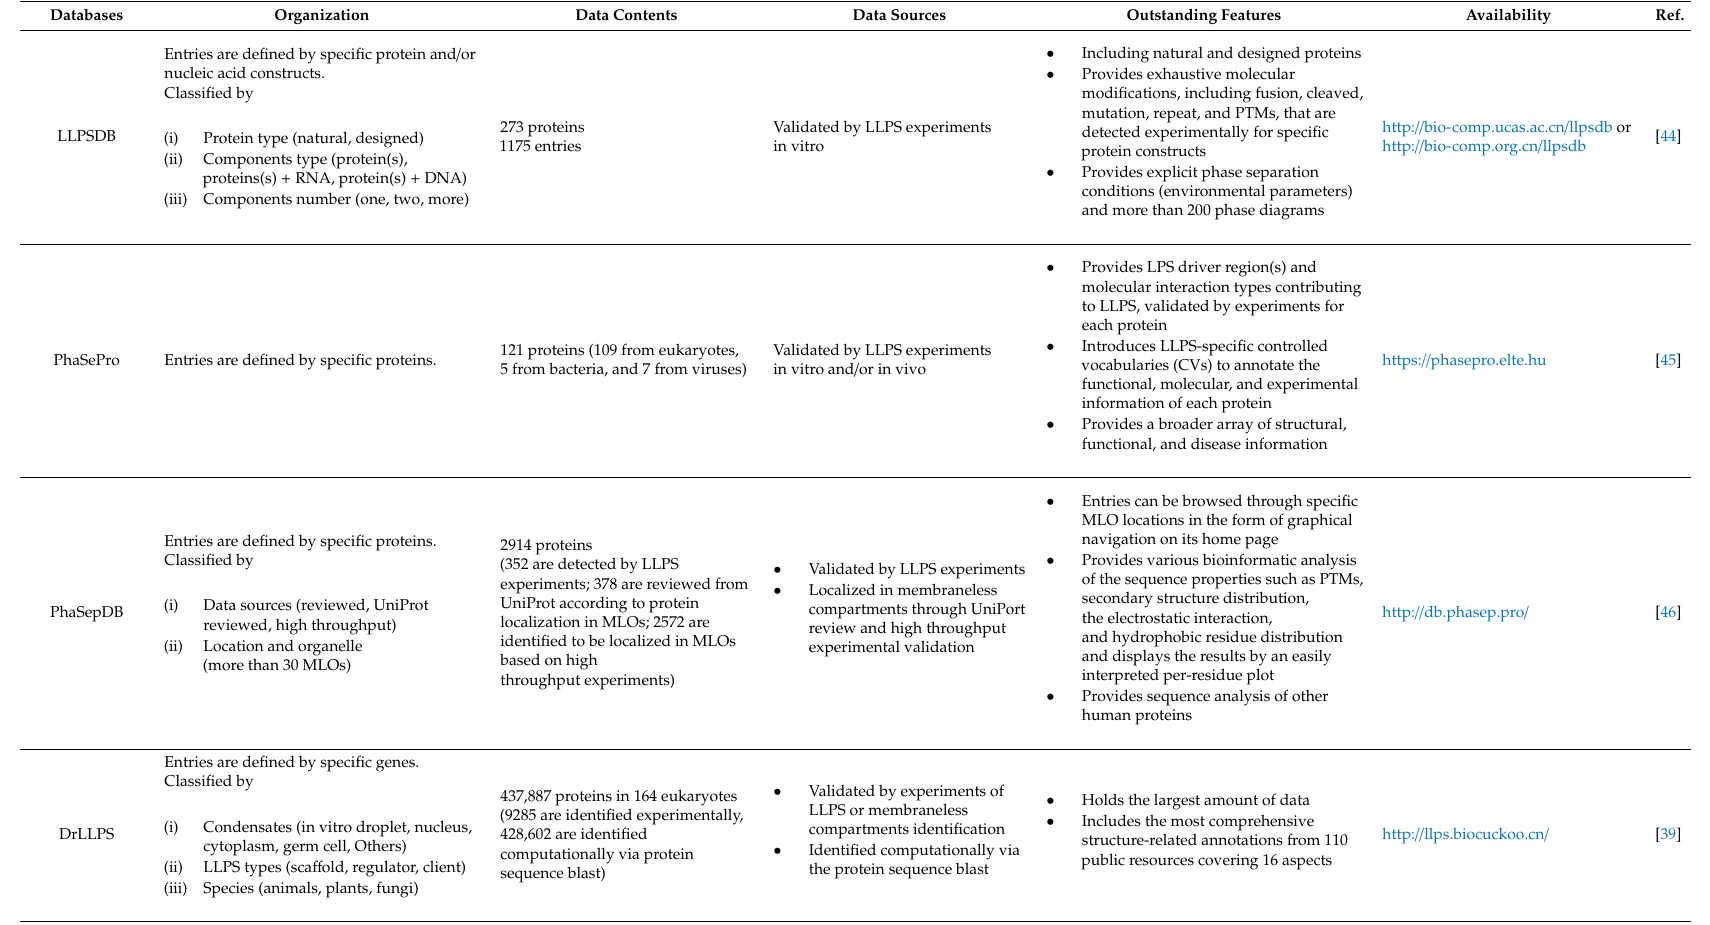
Table 1. Overview of six databases related to liquid–liquid phase separation